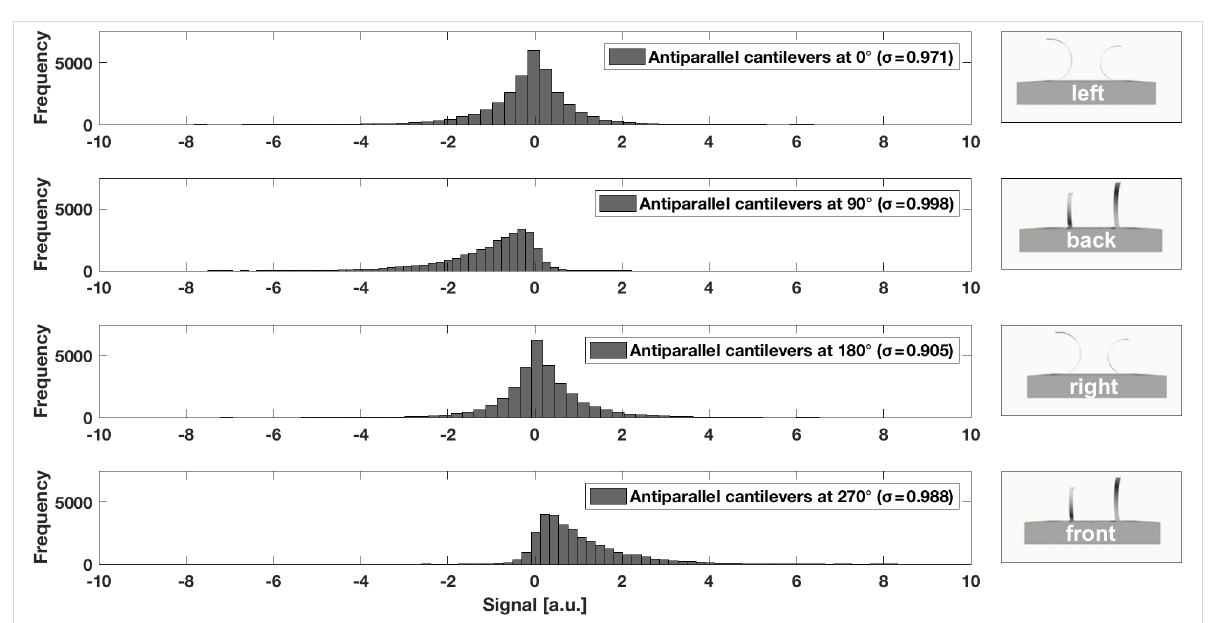
Figure 11: Average mean distribution of 30,000 measurement values for the antiparallel artificial hair sensors at rotation angles 0°, 90°, 180°, and 270°. Standard deviations ( σ ) are listed in the legend.